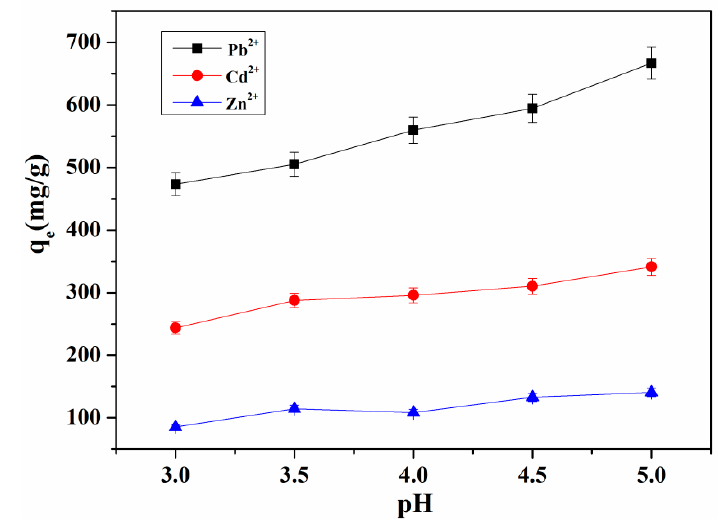
Figure 9. The influence of pH on the adsorption property of hydrogel.